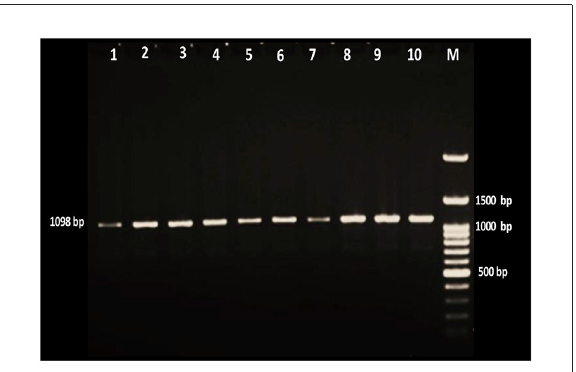
FIGURE2 Gel electrophoresis of amplified Theileria positive products with ethidium bromide stain. Lane M is a 100-bp DNA ladder, and lanes 1–10 were positive samples for the Theileria parasite.